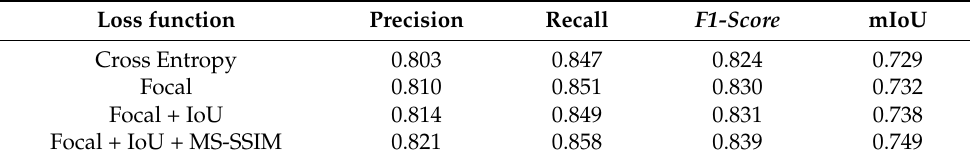
Table 5. Performance indicators based on loss function.